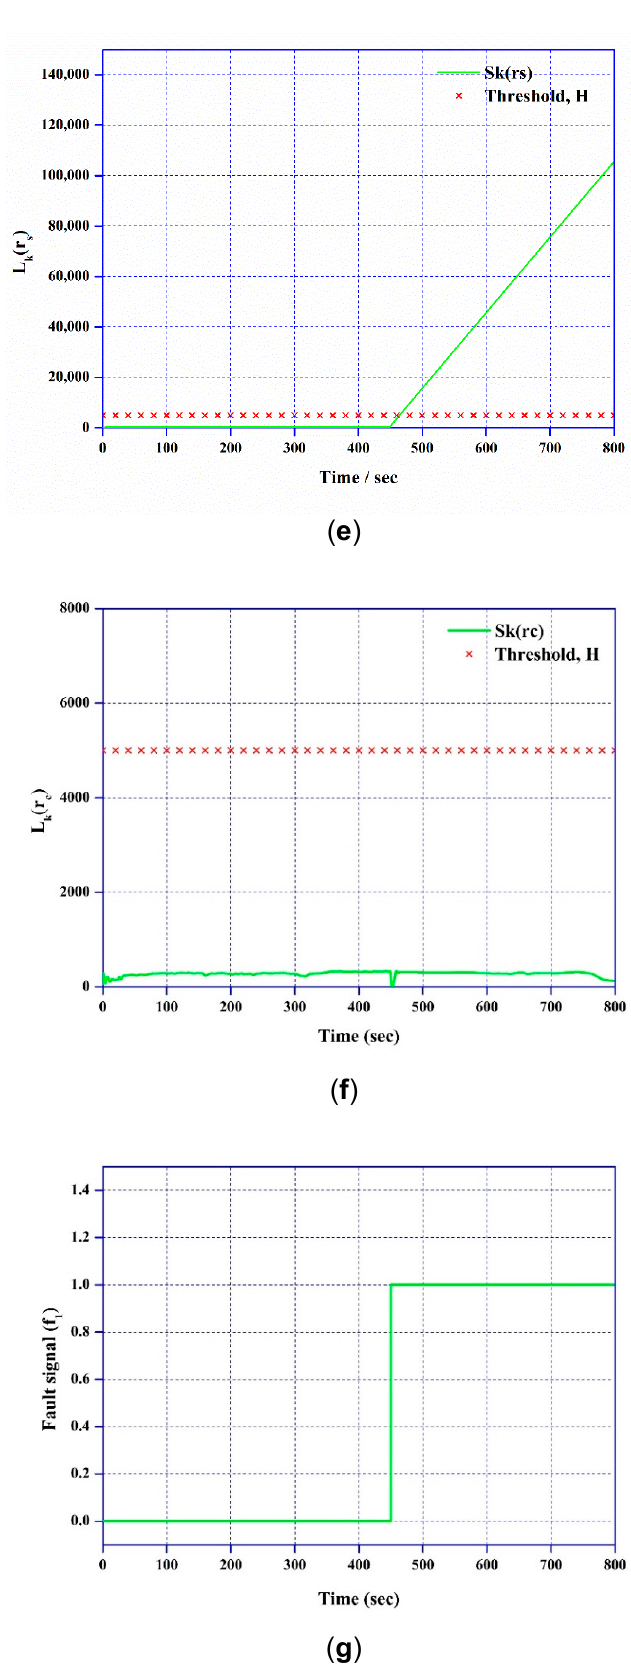
Figure 7. Sensor measurements, residuals and detection results in the stack stuck fault of